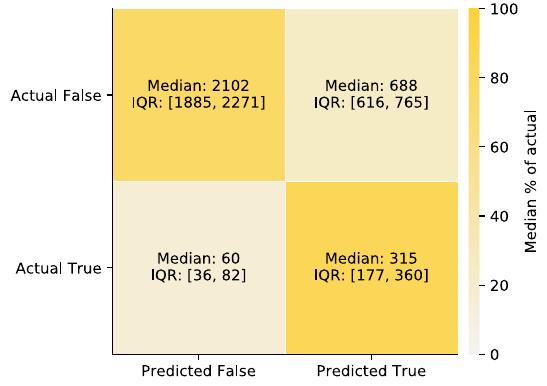
Fig. 5 Confusion matrix for the reduced feature sets across splits. Confusion matrix for the predictions of the test sets based on the optimal decision threshold based on the Youden ’ s J statistic. True refers to entering critical state, and False refers to not entering critical state. The shades of the confusion matrix correspond to the median percentage of the actual labels (i.e., shade of the top left cell and the bottom right cell represent the median speci fi city and the median sensitivity,